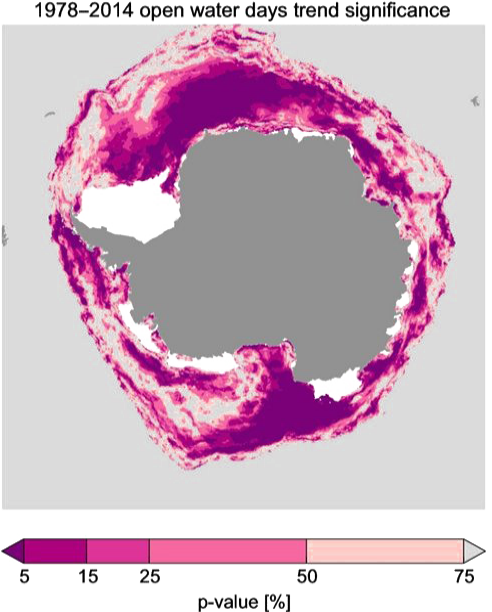
Figure 15. The probability that the trend in Fig. 14 is not significant (test of the null hypothesis). A low value ( < 5%) indicates that the trend is in fact